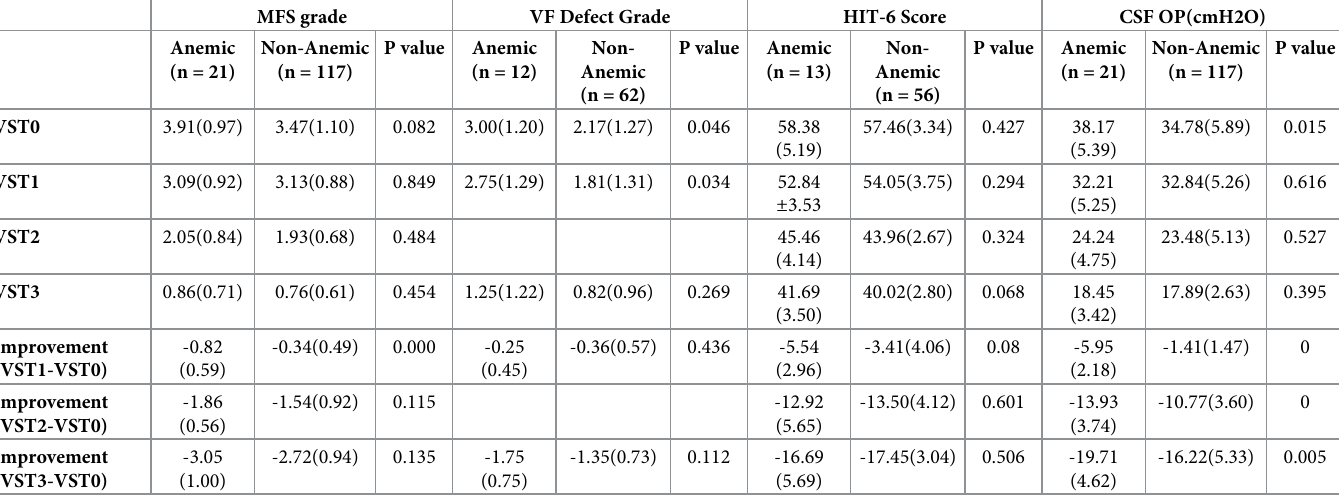
Table 4. Comparison of follow-up information in anemia group and non-anemia group.